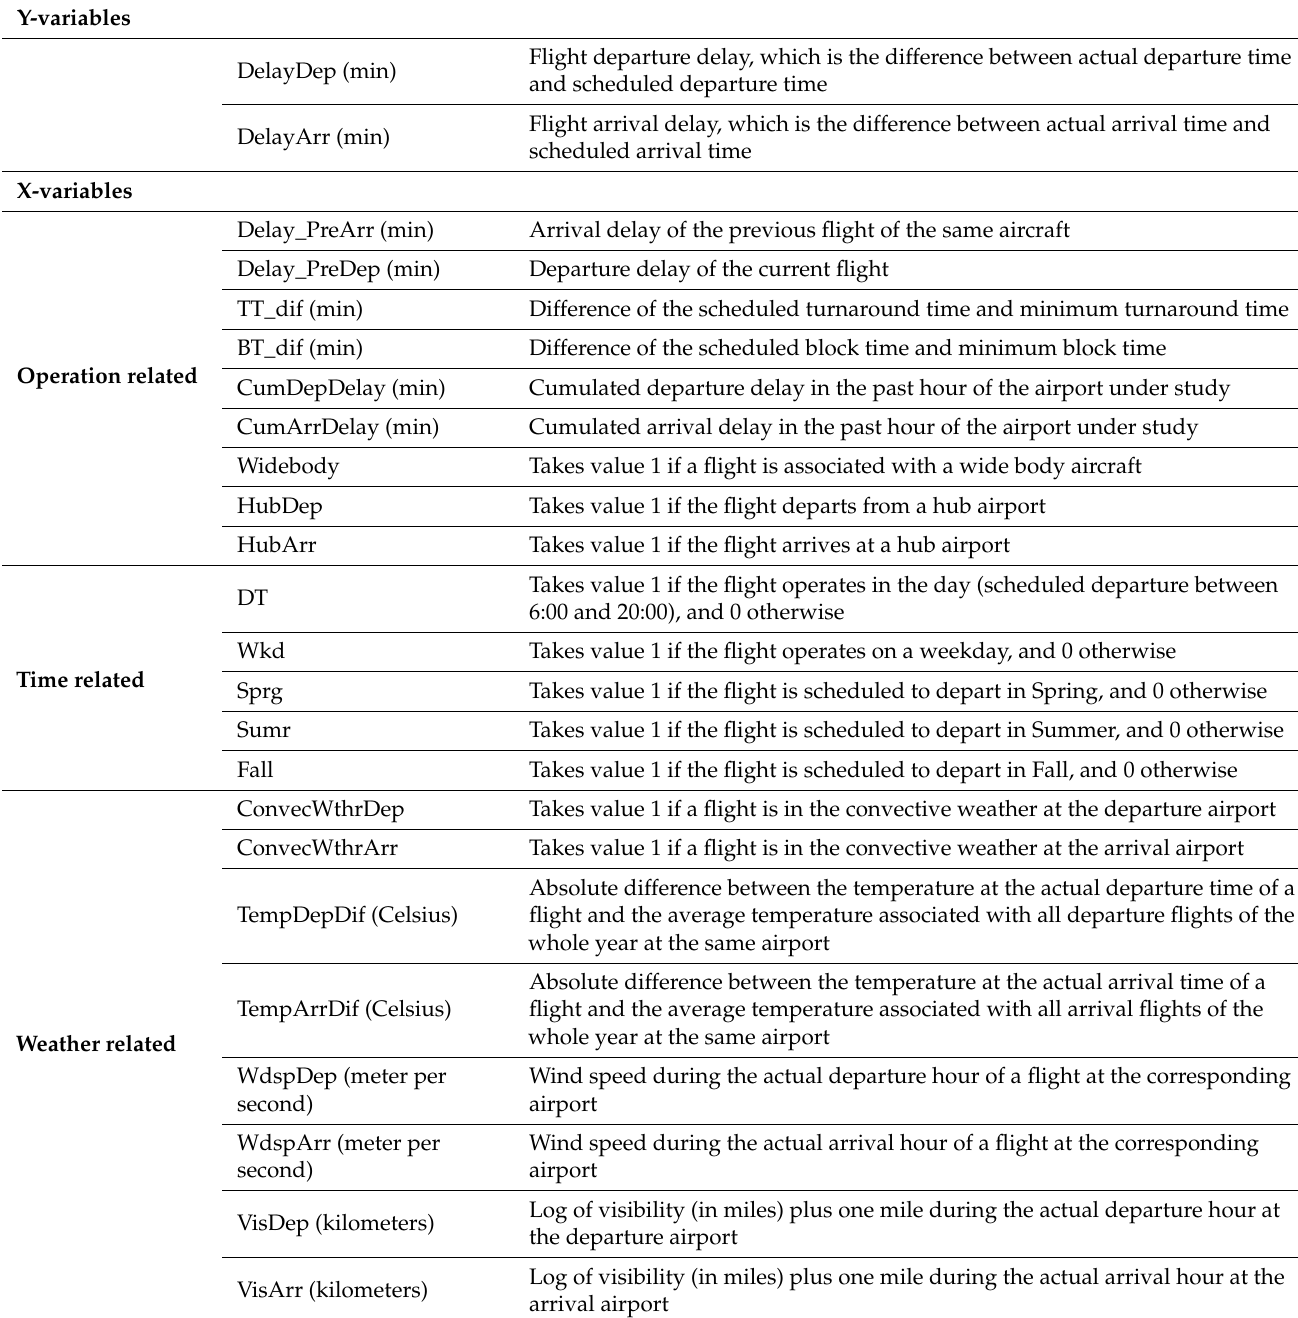
Table 1. Description of